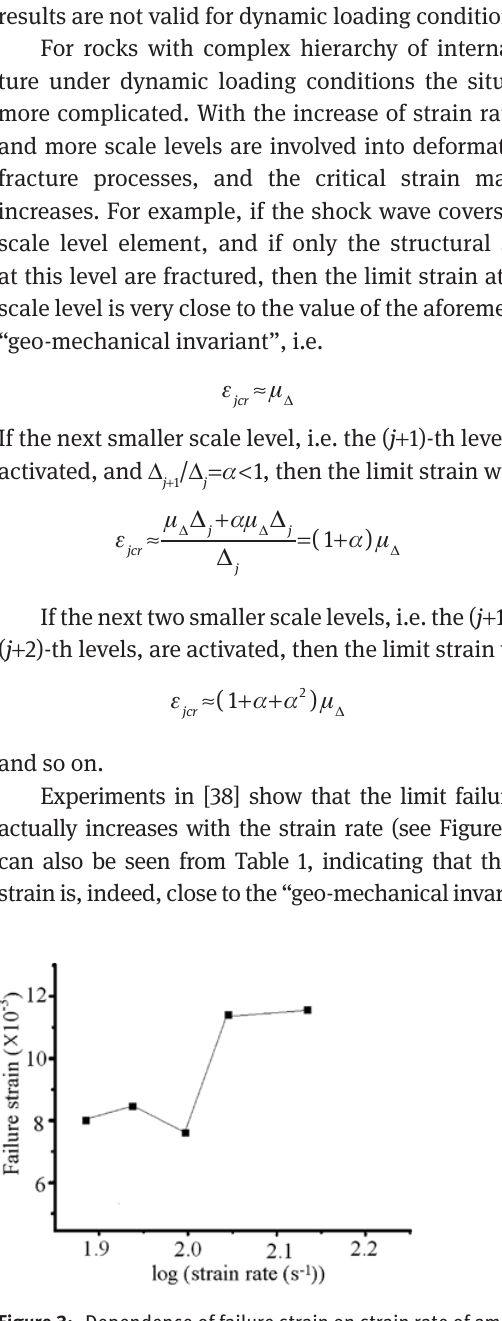
Figure 4: Dependence of dynamical strength on strain rate in